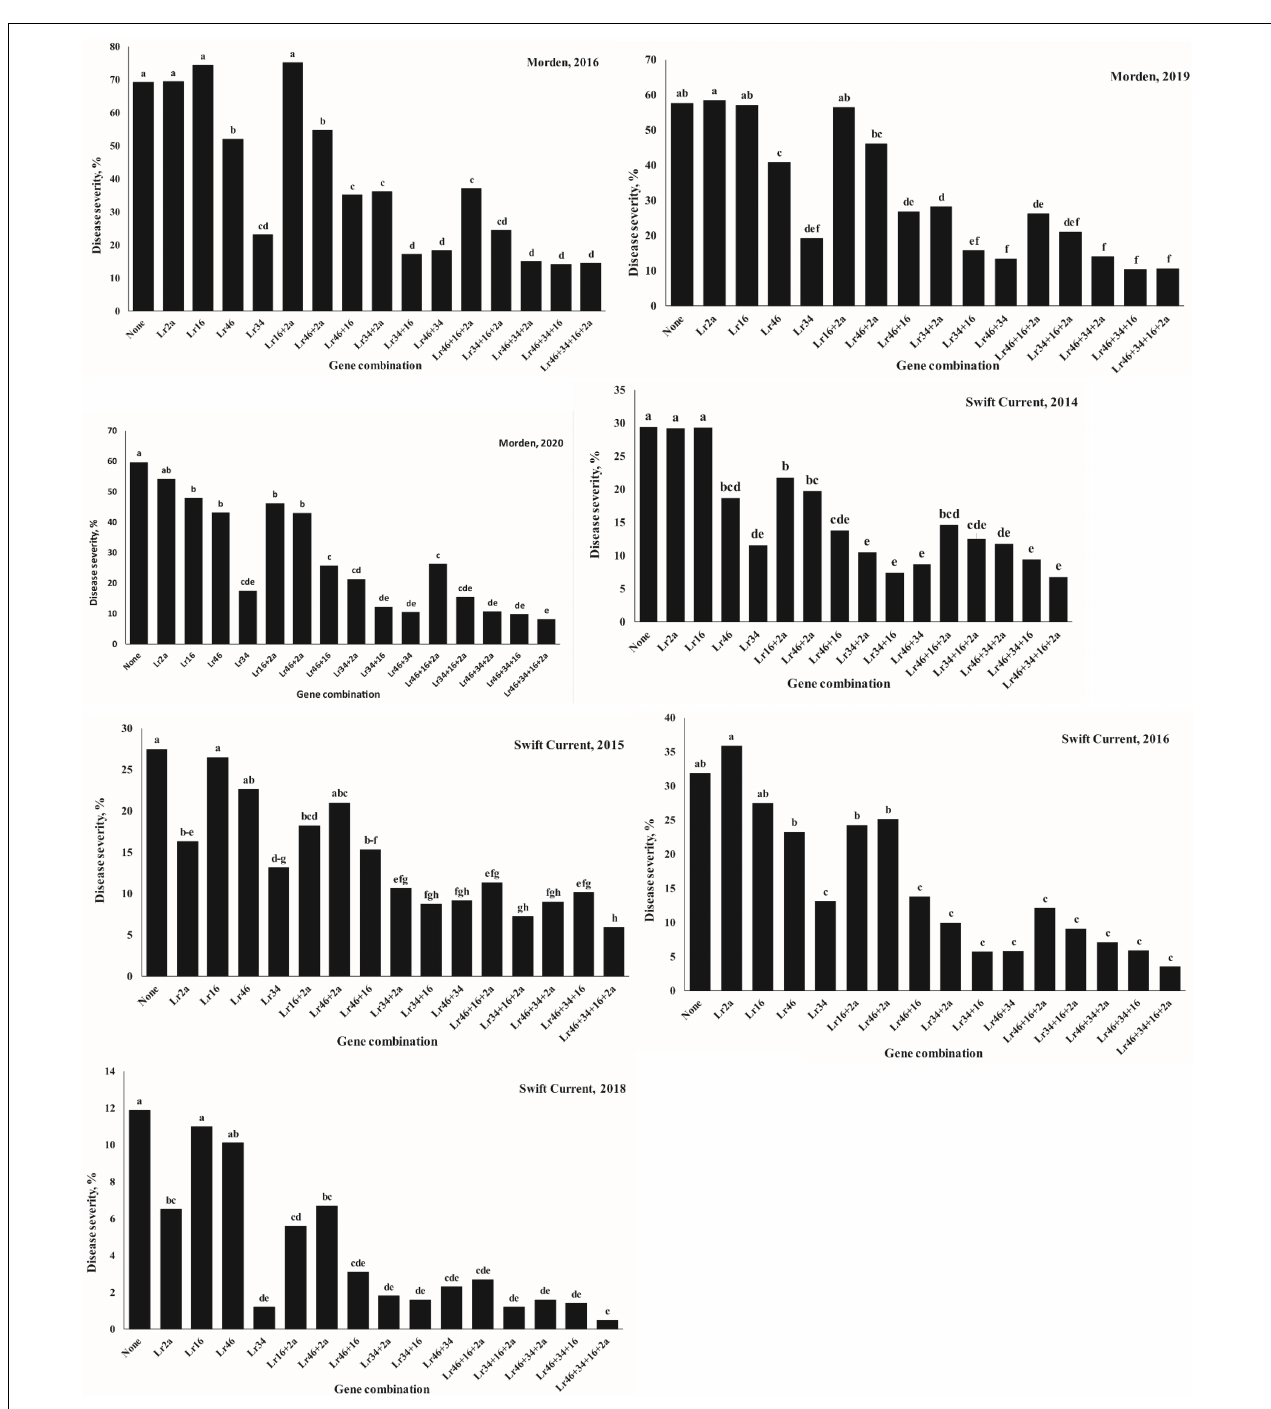
FIGURE 4 | Effects of gene combinations on adult plant leaf rust response in the Carberry/Thatcher population evaluated near Morden, AB and Swift Current, SK in different